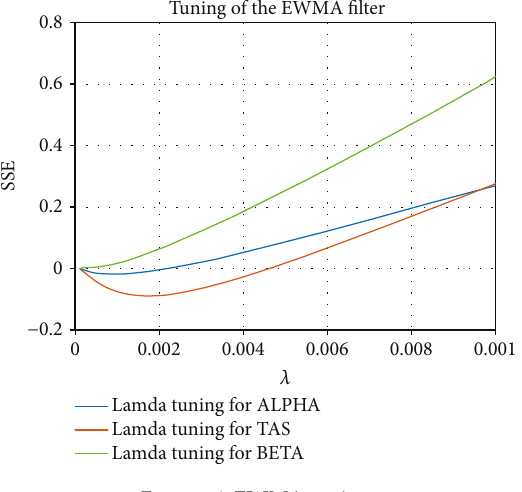
Figure 6: EWMA tuning.